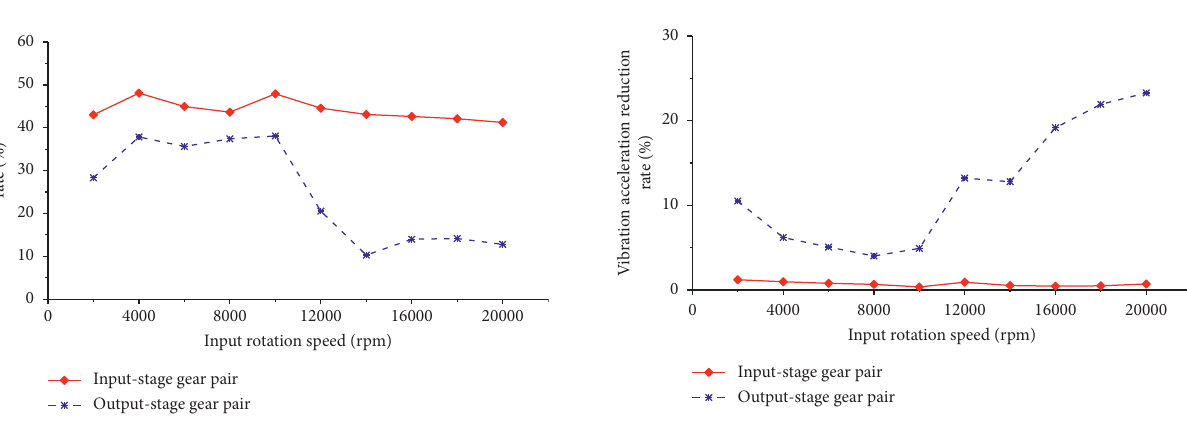
Figure 30: Vibration reduction effect of the system with the modification of input-stage pinion.